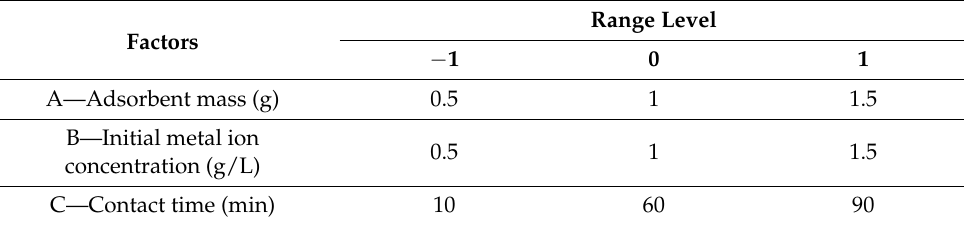
Table 5. Experimental ranges and levels in the experimental design.